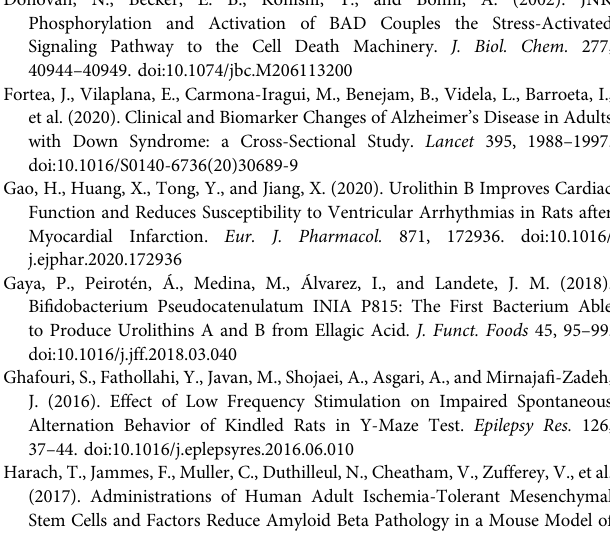
Supplementary Figure 1 | The in vitro antioxidant/antiradical activity of UB was determined using four systems: (A) ABTS + radical scavenging assay; (B) DPPH radical scavenging assay; (C) OH – radical scavenging assay; (D) O 2 radical scavenging assay. All results are described as means ± SD ( n (cid:1) 6 per group). SupplementaryFigure2 |EffectofUBonAch-E (A) andMAO (B) activities inbrain tissue of aging mice. Effect of UB on the activities of CAT (C) , GSH-Px (D) , SOD (E) , T-AOC (F) and MDA levels (G) in the brain tissue of aging mice. Effect of UB on the levels of TNF- α (H) , IL-1 β (I) and IL-6 (J) levels in the brain tissue of mice. All results are described as means ± SD ( n (cid:1) 6 per group). # p < 0.05 and ## p < 0.01 vs the control group; *p < 0.05 and **p < 0.01 vs the D-gal-induced aging group. SupplementaryFigure3 |UBinhibited theactivationofastrocytes andmicrogliain D-gal-induced aging mice. Representative magni fi ed images of immunohistochemistry of GFAP (A) and IBA1 (B) in the hippocampal CA2 region. Immunohistochemistry of GFAP (C) and IBA1 (D) in the hippocampus of each group. The statistical analysis of GFAP + (E) and IBA1 + (F) cells per fi eld ( n (cid:1) 6 per group). (G) Protein expression of GFAP and IBA1 was detected using western blotting. Quanti fi cation analysis of IBA1 (H) and GFAP (I) . β -actin served as an internal control ( n (cid:1) 6 per group). All results are described as means ± SD. # p < 0.05 and ## p < 0.01 vs the control group; * p < 0.05 and ** p < 0.01 vs the D-gal-induced aging group. Supplementary Figure 4 | Effect of UB on memory impairment and hippocampal pathology in 2-monthand 12-month-old mice. (A) Escape latencies in the training trial ( n (cid:1) 12 per group). (B) Escape latencies of aging mice on day 5 in the training trials ( n (cid:1) 12 per group). (C) Time spent in the target quadrant during the probe test ( n (cid:1) 12 per group). (D) Number of platform location crosses by mice ( n (cid:1) 12 per group). (E) Representativetracesonthelastdayoftheprobetest( n (cid:1) 12pergroup). (F) Expression of PSD95 and Syn wasmeasured by western blotting. Quanti fi cation analysis of Syn (G) and PSD95 (H) . β -actin served as an internal control ( n (cid:1) 6 per group). (I) Representative Golgi staining of the hippocampal CA3 region. Representative high magni fi cation images (J) and quanti fi cation of the spine number (K) in aging mice. All results are described as means ± SD. # p < 0.05 and ## p < 0.01 vs the control group; *p < 0.05 and **p < 0.01 vs the 12-month-old aging group. SupplementaryFigure5 |UBinhibited theactivationofastrocytes andmicrogliain the hippocampus of 2-month- and 12-month-old mice. Representative immuno fl uorescence image of GFAP (A) and IBA1 (B) in hippocampal tissue of normal young mice and naturally senile mice. The statistical analysis of GFAP + (C) and IBA1 + (D) cells per fi eld ( n (cid:1) 6 per group). (E) Protein expression of GFAP and IBA1 was measured by western blotting. Quanti fi cation analysis of GFAP (F) and IBA1 (G) . β -actin served as an internal control ( n (cid:1) 6 per group). All results are described as means ± SD. # p < 0.05 and ## p < 0.01 vs the control group; *p < 0.05 and **p < 0.01 vs the 12-month-old aging